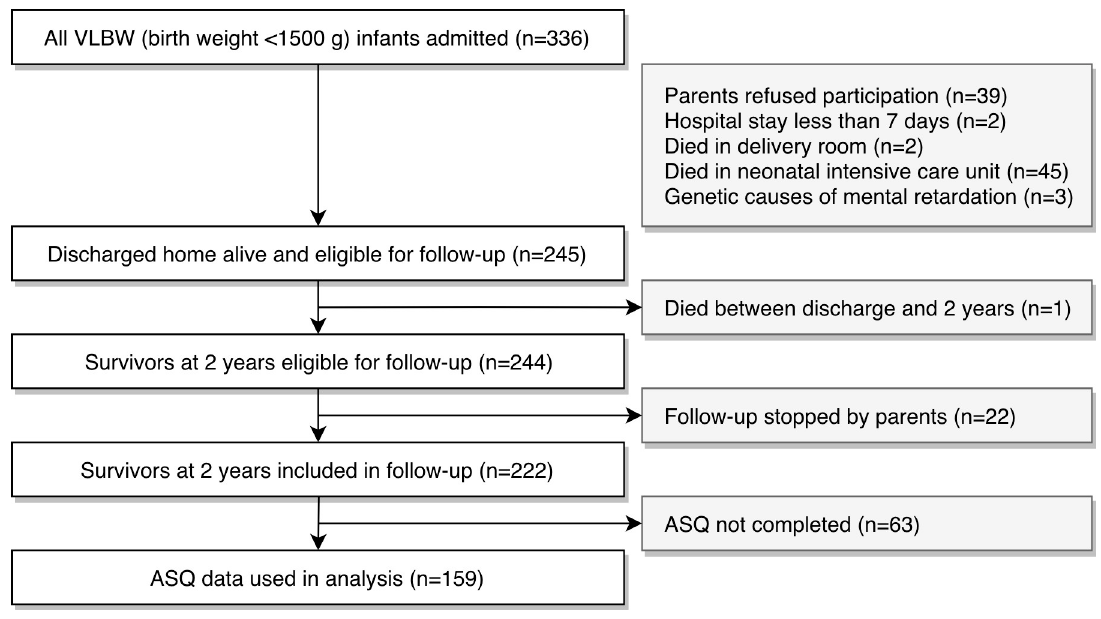
Fig 1. Flowchart. ASQ: Ages and Stages Questionnaire. VLBW: very low birth weight. (185 to 220) and 250 (235 to 261), respectively. Infants in NDI group were more likely male gender (67.3% versus 46.2%, P = 0.02) and experienced more PDA ligation (20% versus 5.8%, P = 0.01) than control.